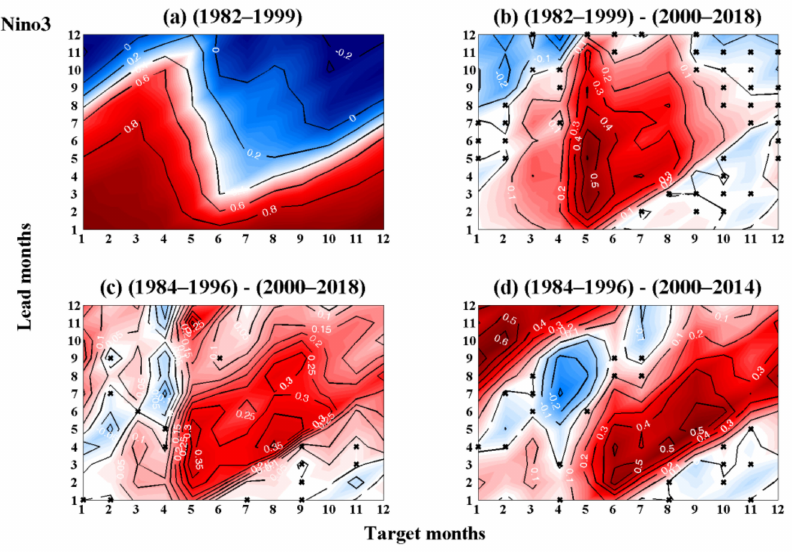
Figure 5. As in Figure 4, but for the observed Niño3